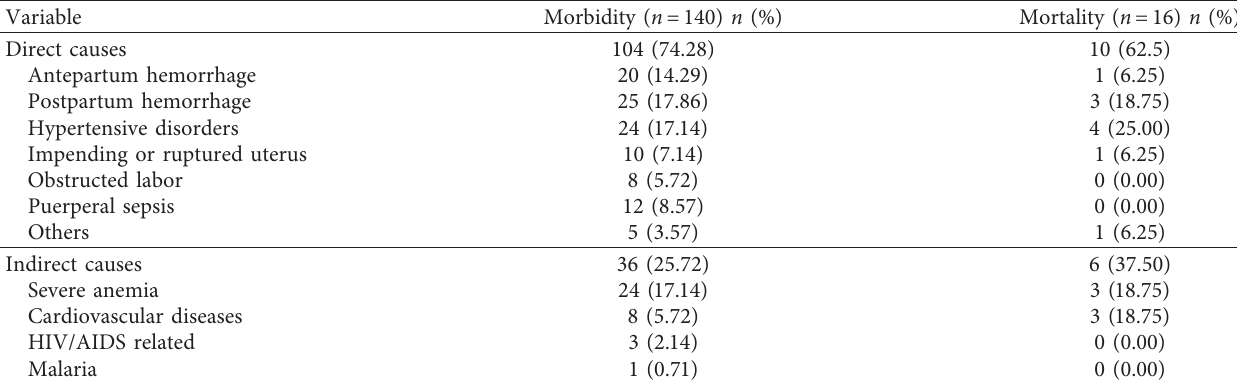
Table 3: Direct and indirect causes of maternal morbidity and mortality among pregnant women with SMO, DRRH, January 2016.